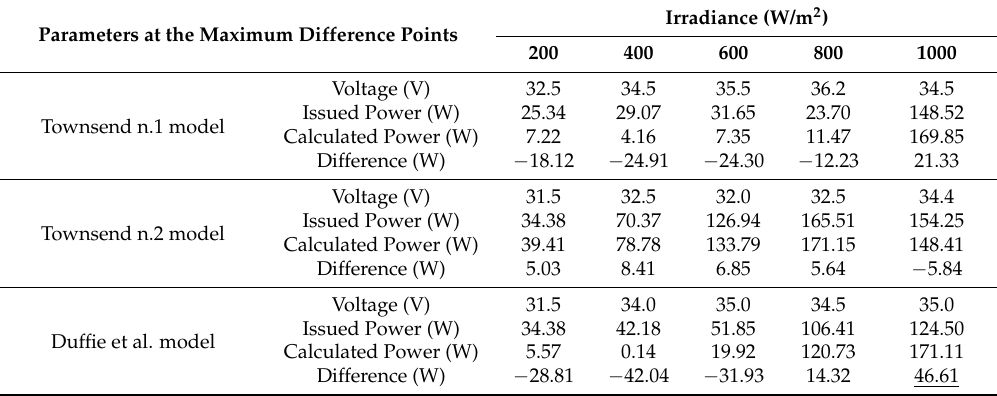
Table 11. Maximum power differences between the calculated and the issued I-V characteristics of Kyocera KD245GH-4FB2, at temperature T = 25 ◦